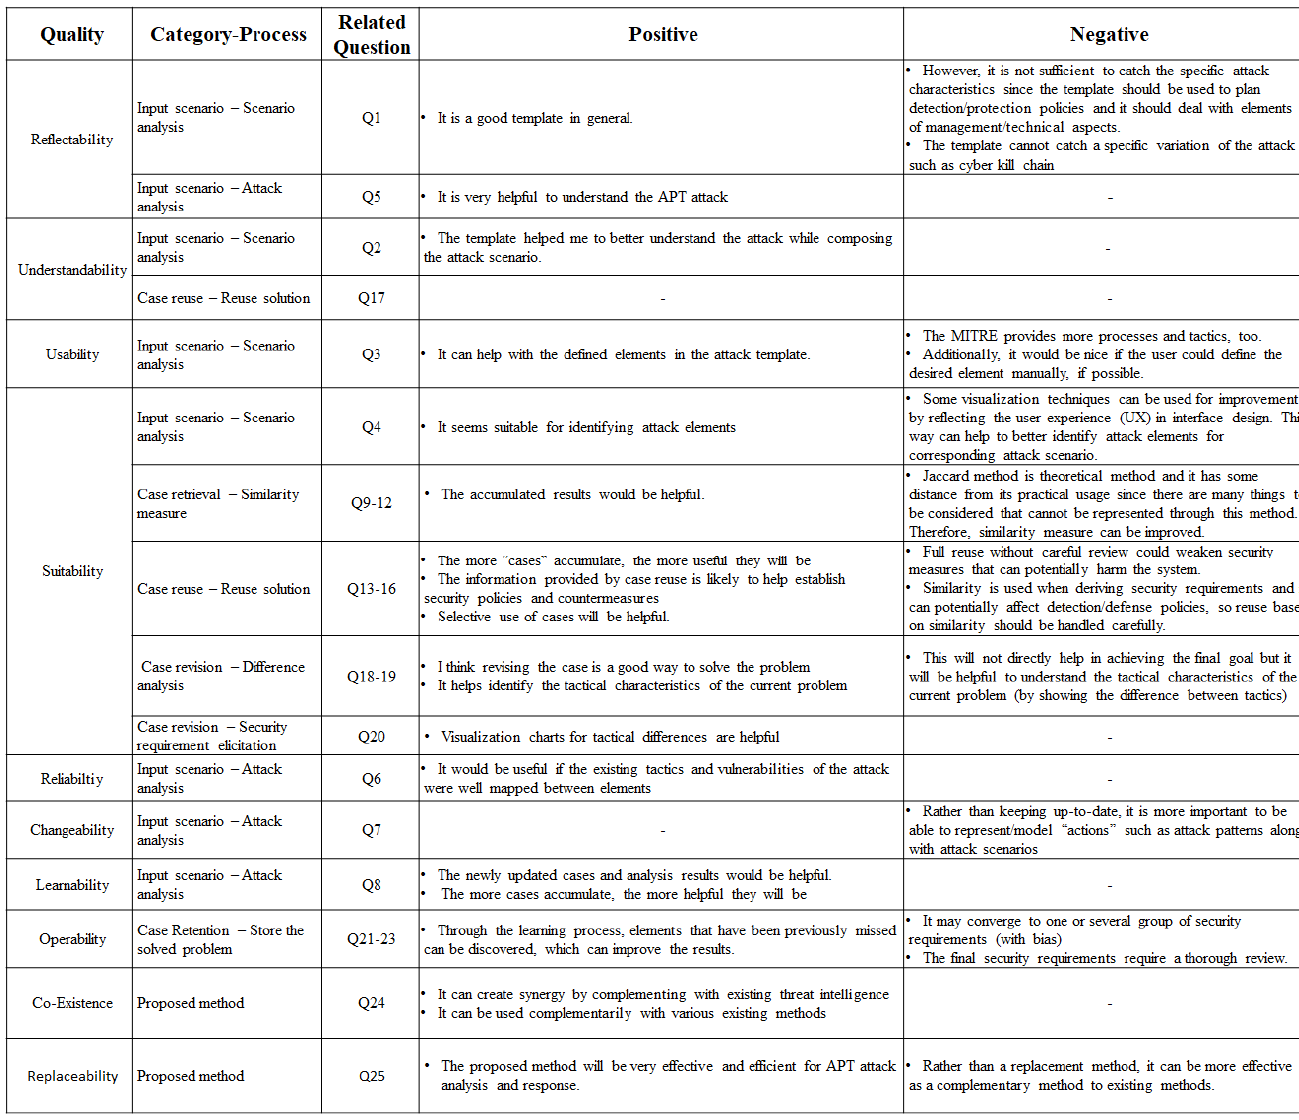
Figure 18. Summary of qualitative evaluation of the proposed method by the experts.